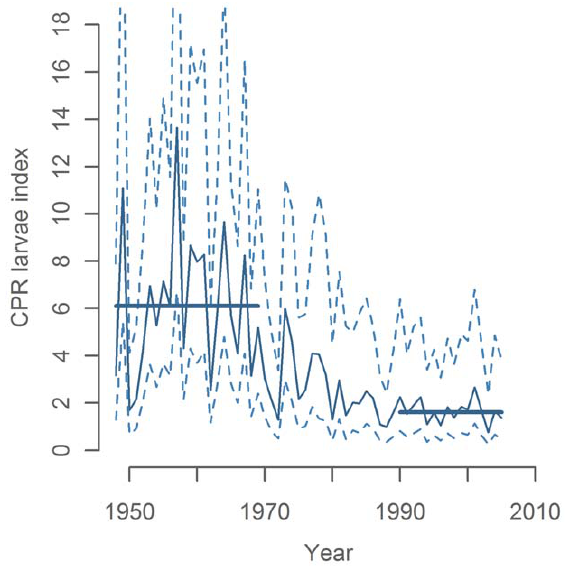
Figure 6. Larvae abundance index with 95% confidence